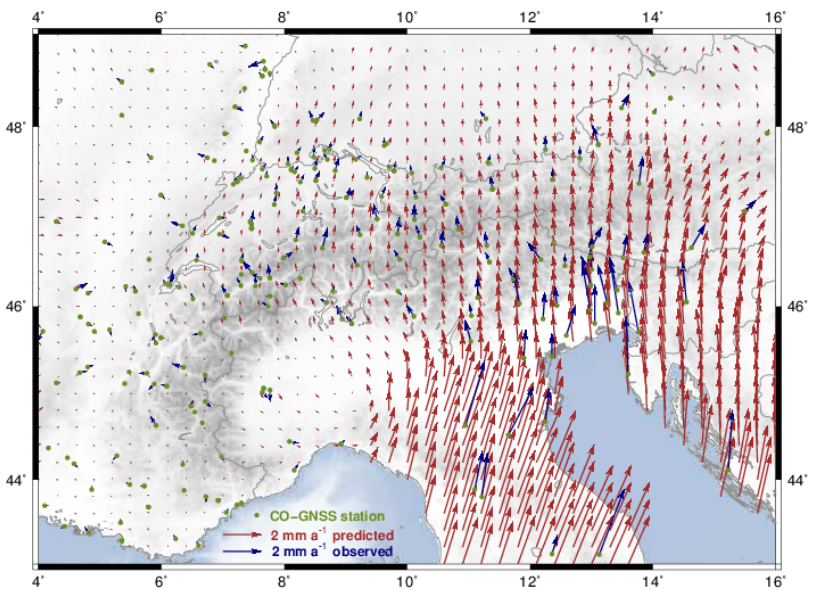
Figure 9. GNSS-inferred horizontal deformation model of the Alpine region. Red arrows represent the predicted surface deformation. Blue arrows represent the input residual velocities. Green dots show the CO-GNSS station distribution. Uncertainty ellipses are separately shown in Fig. 10. Topography and bathymetry after the ETOPO1 model (Amante and Eakins,